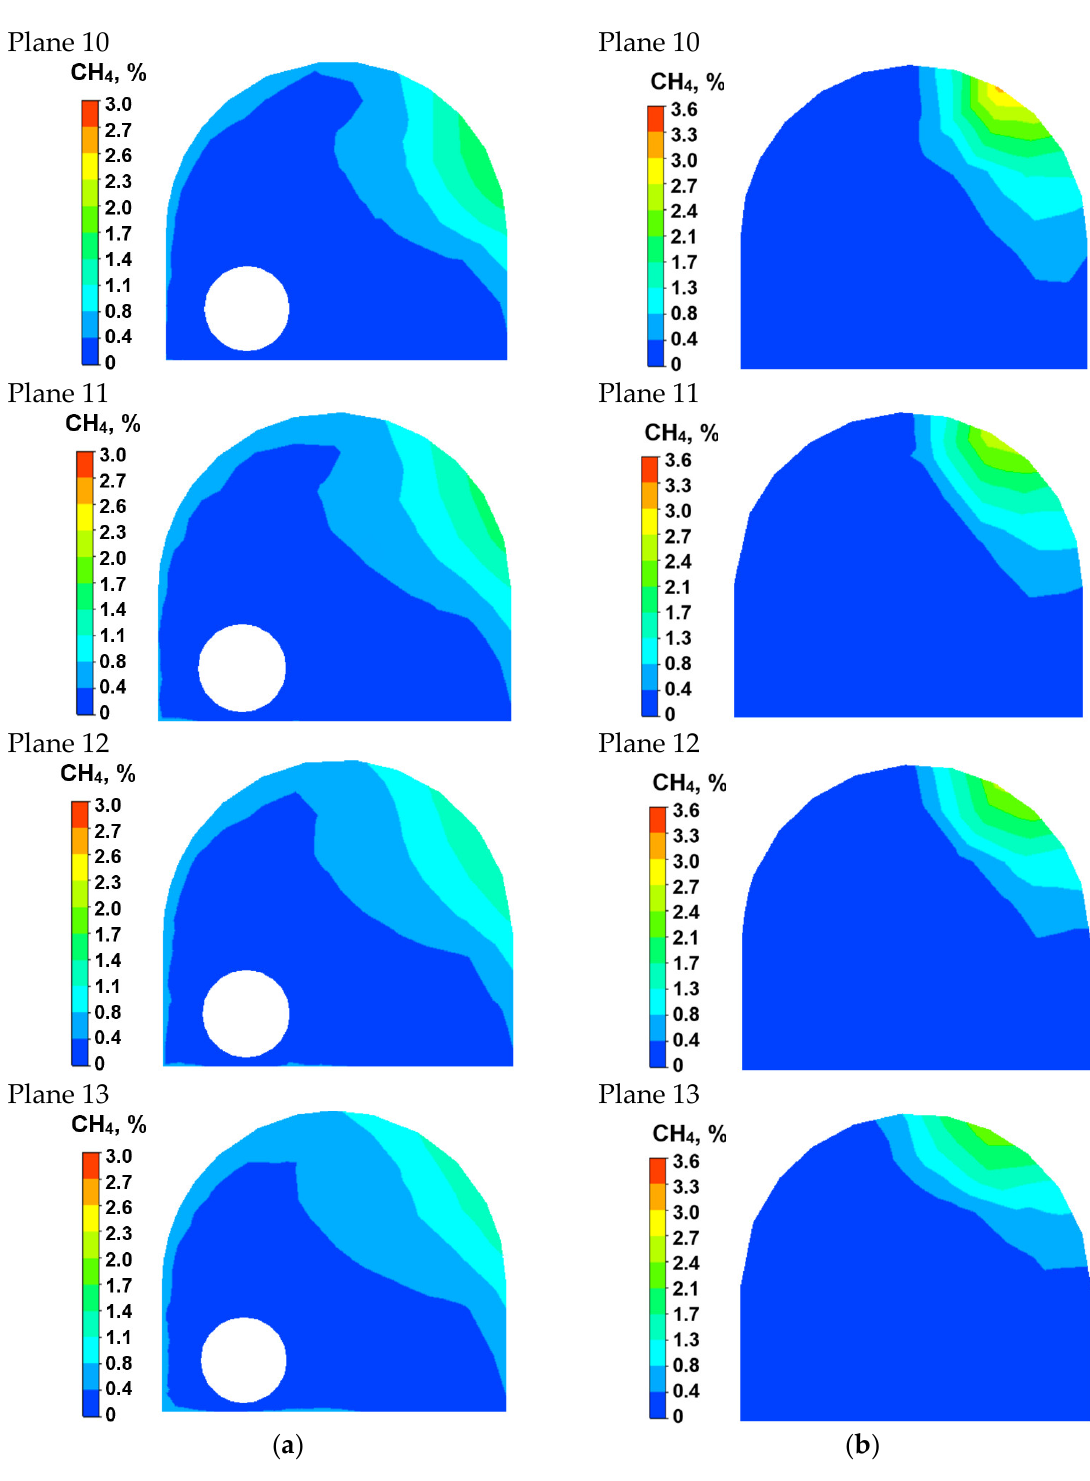
Figure 13. The distributions of methane concentrations in selected vertical sections (Planes 10–13) of the tailgate with built-in AVE ( a ) and without such equipment ( b ).